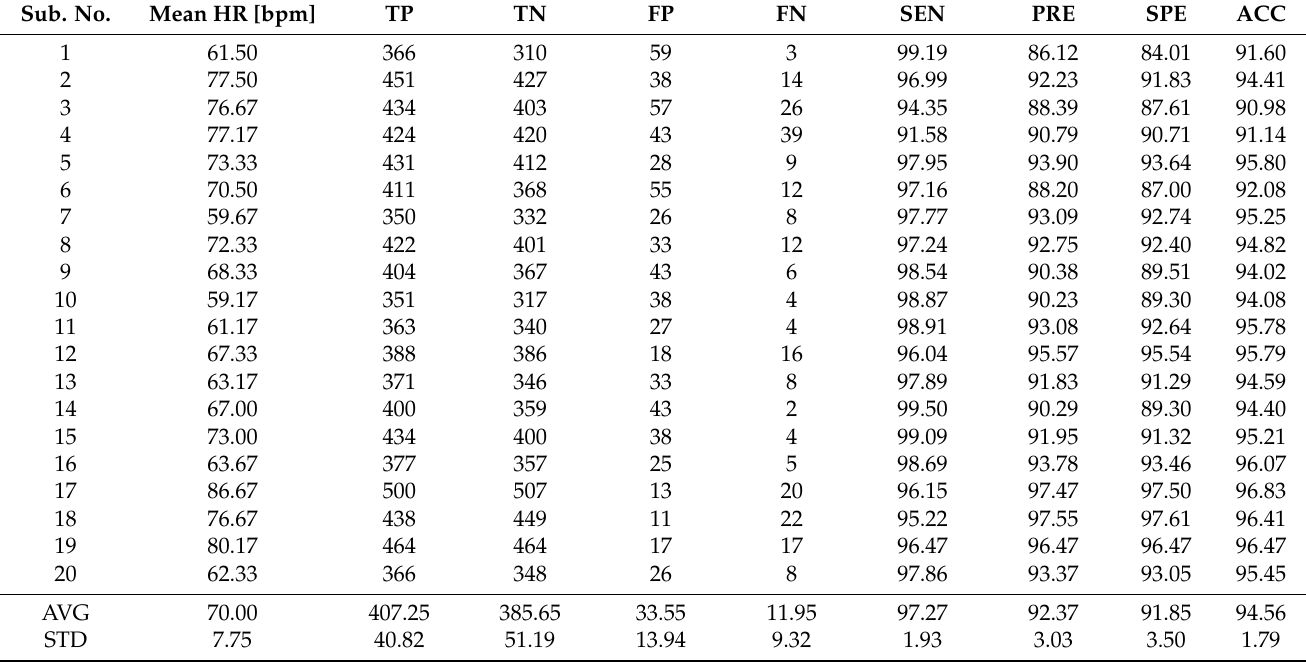
Table 5. Performance of the S1 peak detection in Model II.